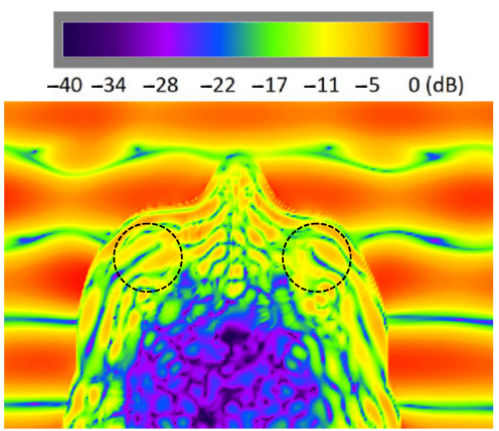
Figure 15. Power density distribution without shield (horizontal polarization); reference value 0 dB = 40 W/m 2 . The regions in the circle are the areas of the eye.